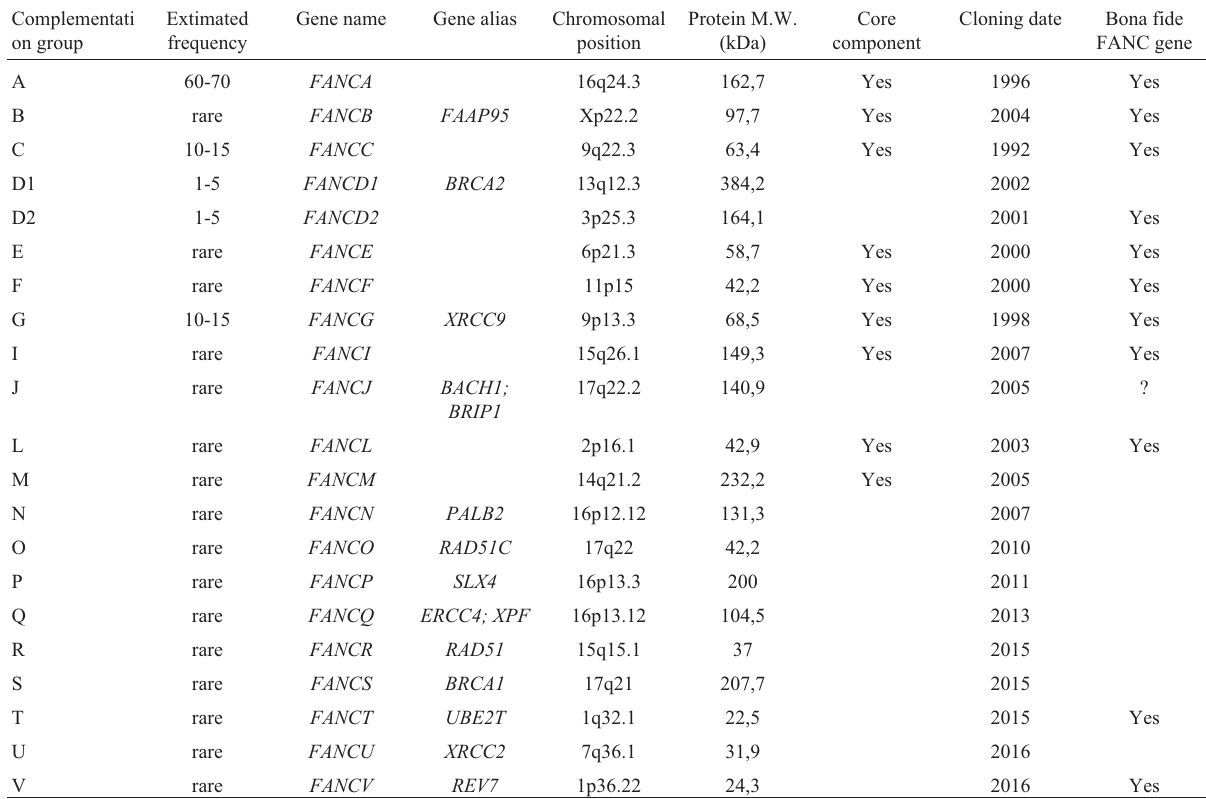
Table 1 - The 21 currently identified FANC and FANC-like genes. Complementati on